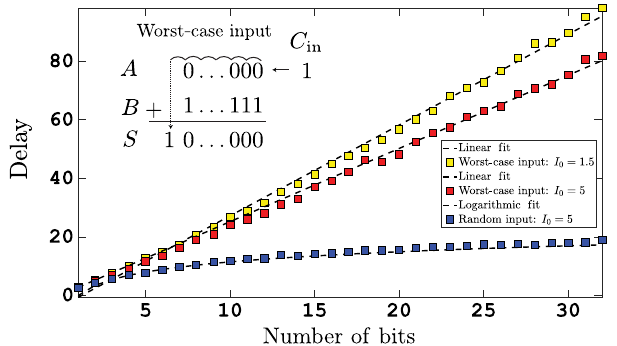
FIG. 12. Ripple carry adder delay. The delay of the RCA as a function of number of bits in the ripple carry adder is shown. The worst-case input combination generates a carry that propagates all the way through bit 1 to bit N , and has a linear dependence on the number of bits, exhibiting O ð n Þ complexity. When the inputs are random, the delay increases logarithmically. The delay is defined to be the time it takes for the network to reach the mode of the array for T ¼ 200 after getting quenched at t ¼ 0 . Each point is an average of 500 trials with random initial conditions for an I 1 . 5 , and the mode of the array is exactly equal to the 0 ¼ arithmetic sum of the inputs in each case. The worst-case inputs are A ¼ 0 … 000 and B ¼ 1 … 111 with an input carry ( C Results show a weak I 0